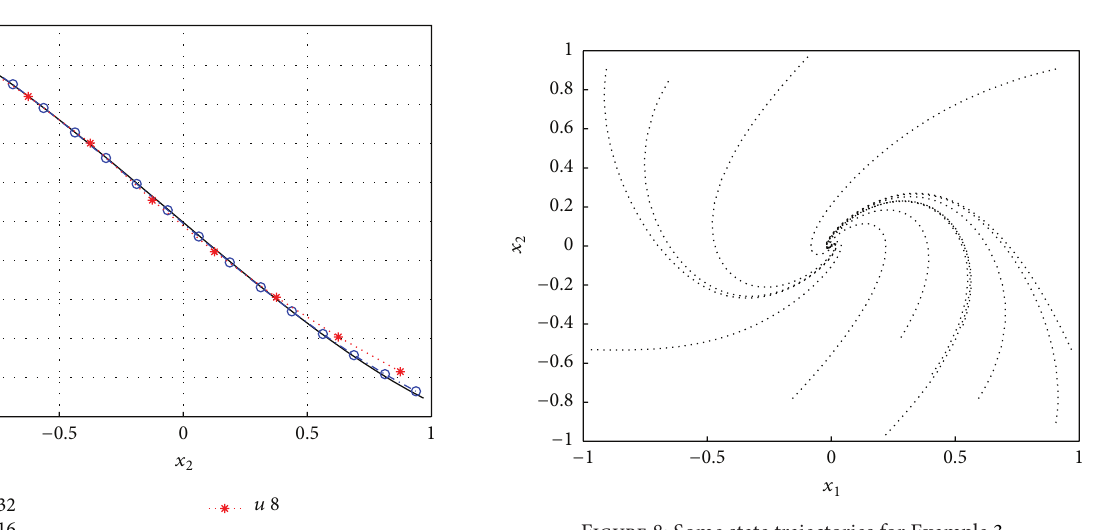
Figure 7: Value cost function for Example 3 via the SHWCM with = −0.1250, −0.0625, −0.0313 , respectively. 𝑚 = 8,16, 32 and 𝑥 1